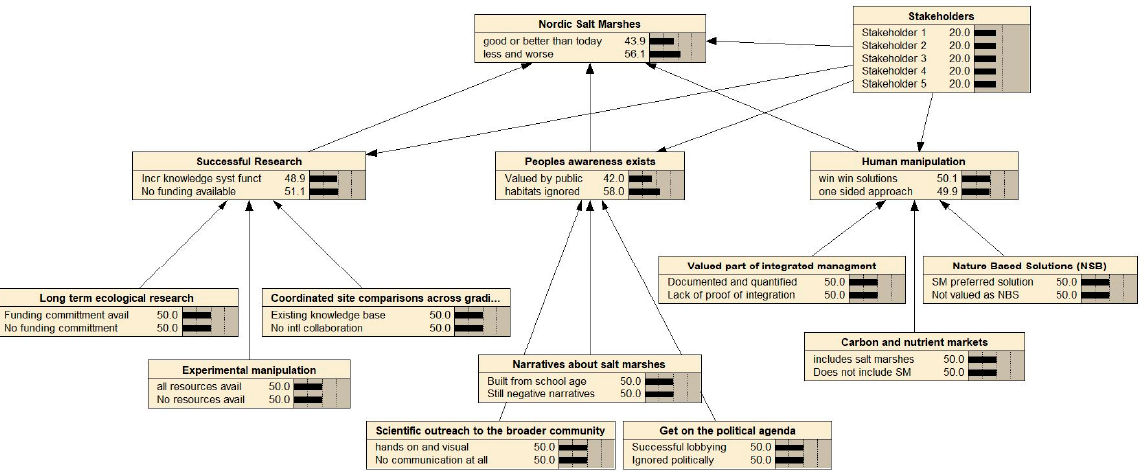
Figure 5. Manipulated probability outputs with specific stem variables being set to 100% (seen in grey).